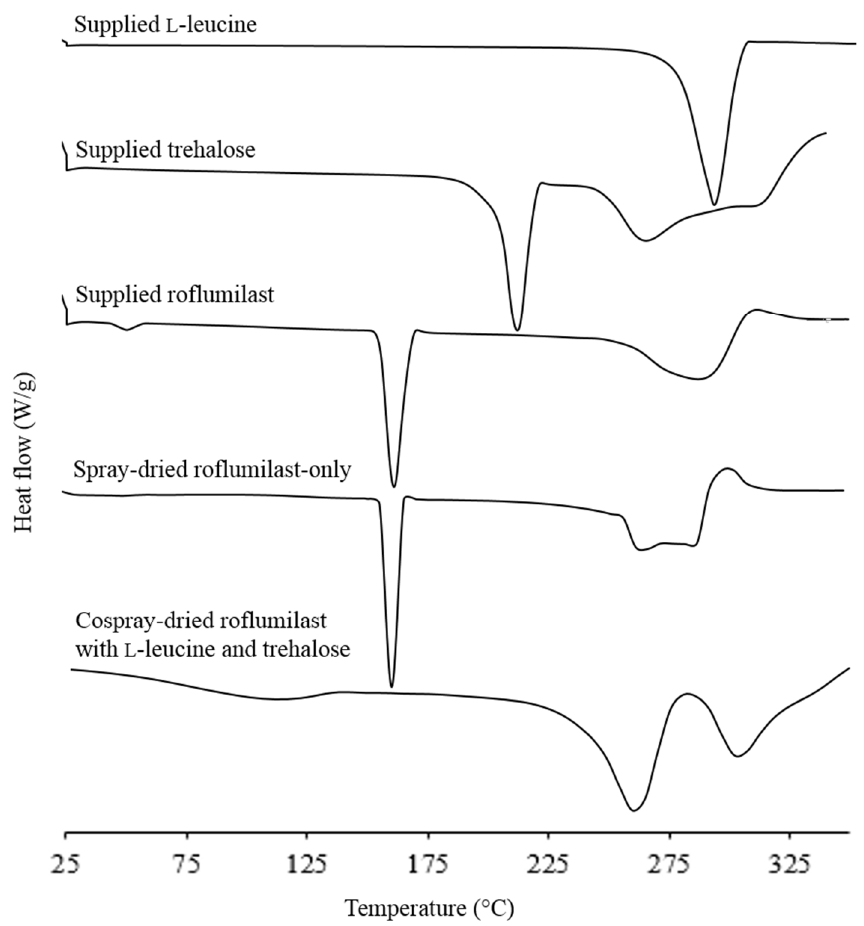
Figure 3. Differential scanning calorimetry (DSC) thermograms of supplied and spray-dried pow ‐ ders.